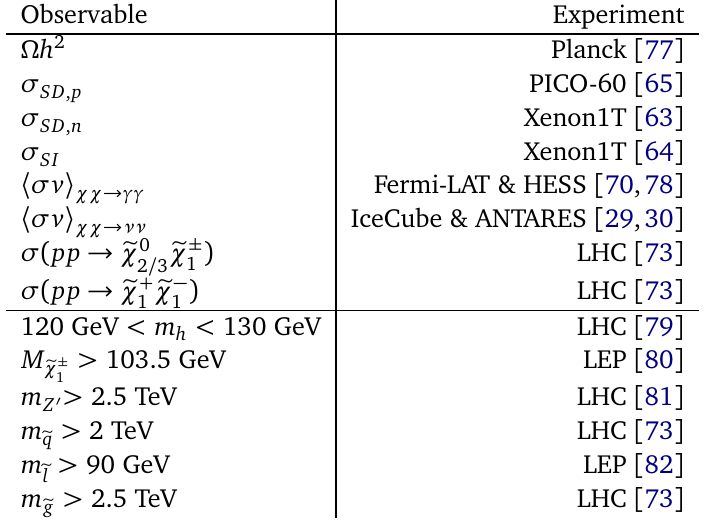
χ − ) ) are χ 0 χ ± ) and σ ( pp → χ + (cid:101) (cid:101) 1 1 1 (cid:101) 2 / 3 (cid:101)